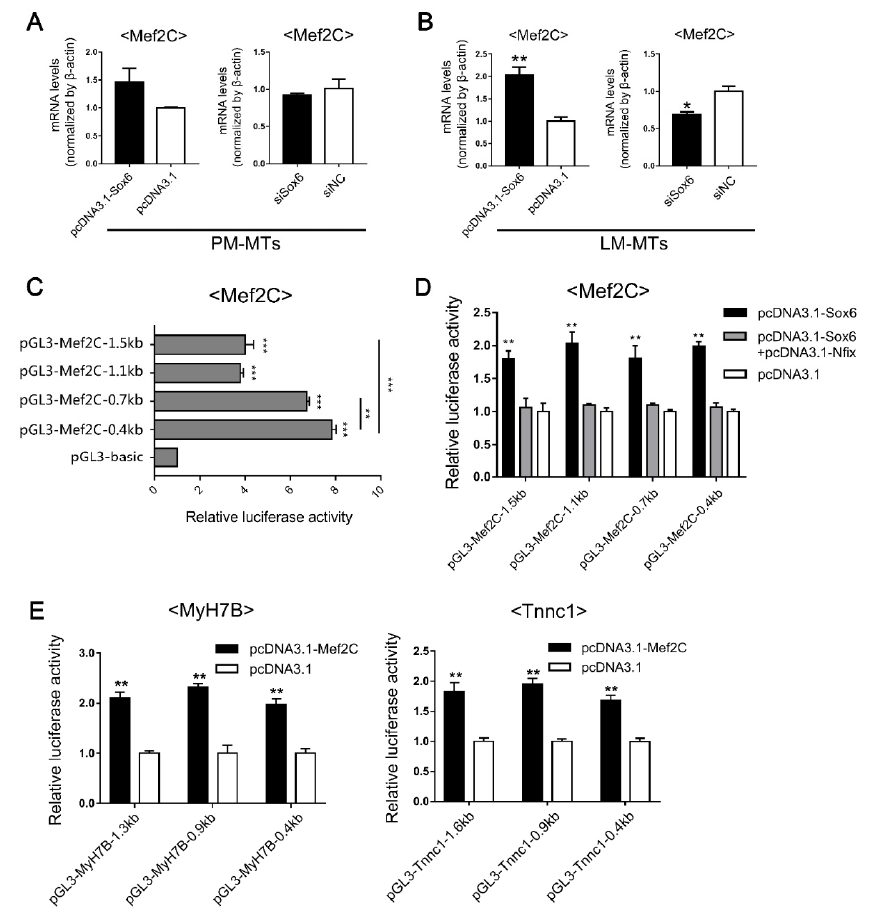
Figure 5. Sox6 indirectly improves the slow-type isoforms through the activation of Mef2C . ( A ) After inducing differentiation for 3 days, the relative expression levels of Mef2C in PM-MTs or ( B ) LM-MTs after overexpression or inhibition of Sox6 were quantified by qPCR (mean ± SEM; * p < 0.05; ** p < 0.01; n = 3; two-tailed Student’s t -test). ( C ) Dual-Luciferase report assay on DF-1 transfected with re- porter vectors containing different lengths of 5 (cid:48) -upstream region of Mef2C (mean ± SEM; ** p < 0.01; *** p < 0.001; n = 6; one-way analysis of variance with Tukey’s multiple comparison test). ( D ) Dual- Luciferase report assay on DF-1 overexpressing Sox6 and Nfix and transfected with reporter vectors containing different lengths of Mef2C 5 (cid:48) -upstream region (mean ± SEM; ** p < 0.01; n = 6; one-way analysis of variance with Tukey’s multiple comparison test). ( E ) Dual-Luciferase report assay on DF-1 overexpressing Mef2C and transfected with reporter vectors containing different lengths of 5 (cid:48) -upstream region of MyH7B and Tnnc1 (mean ± SEM; ** p < 0.01; n = 6; two-tailed Student’s t